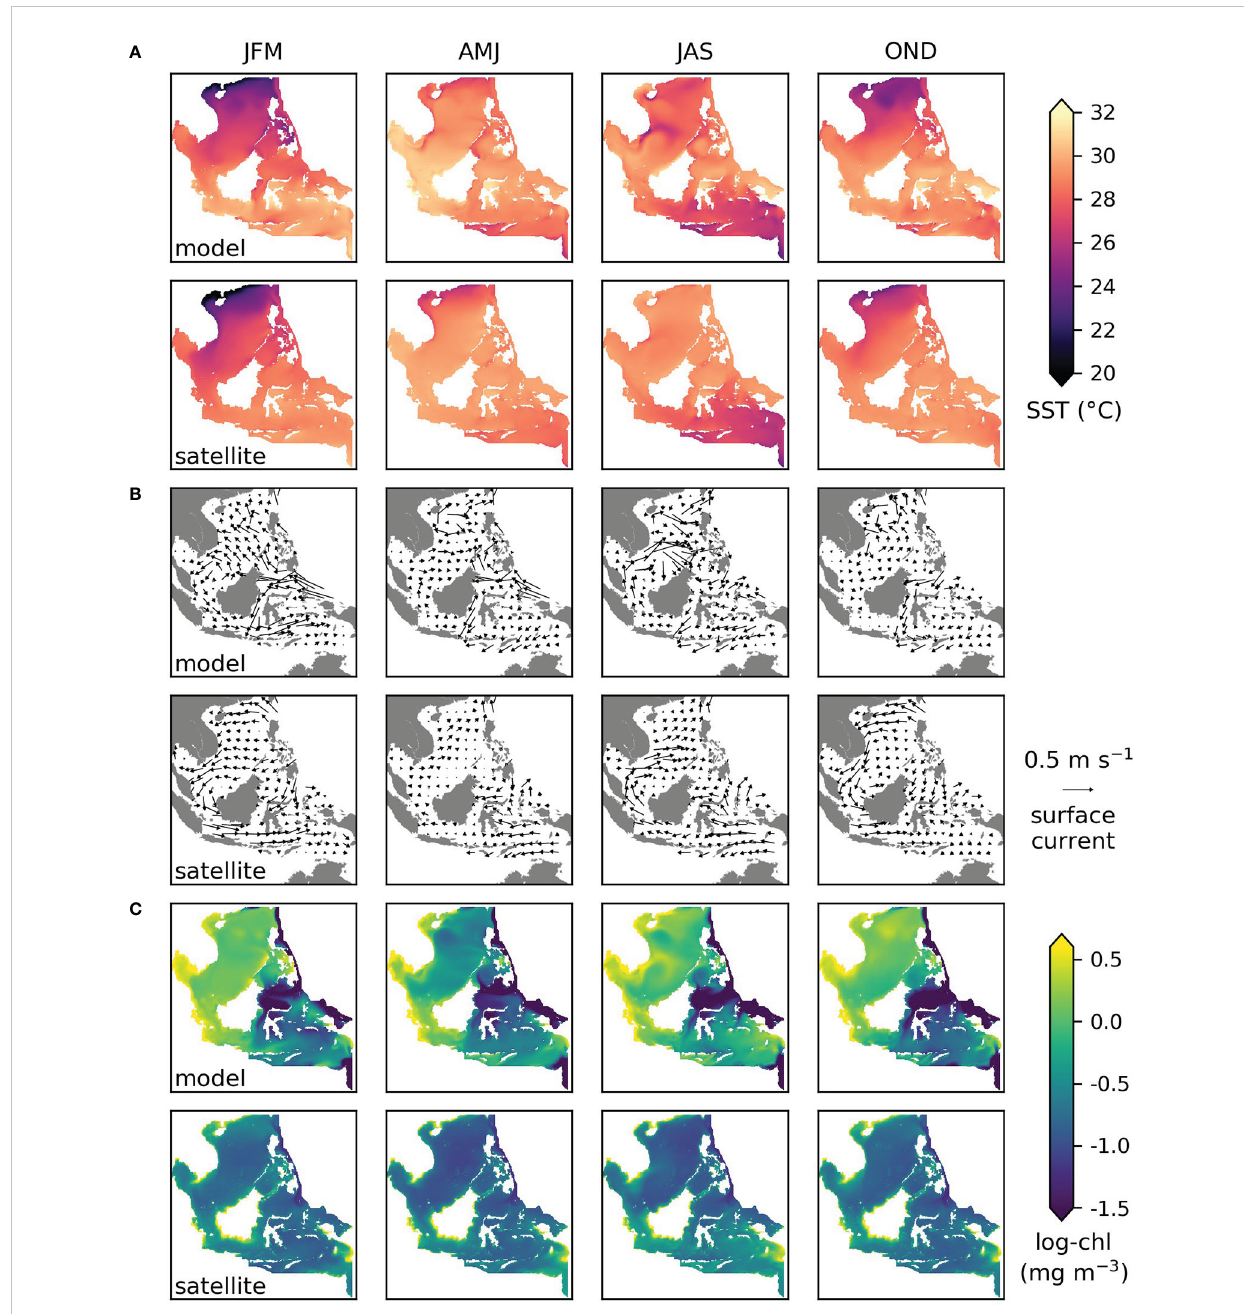
FIGURE 2 Three-month mean conditions for 1998-2017 from the model (upper row) and derived from satellite observations (lower row) for (A) sea surface temperature, (B) surface current speed and direction, (C) surface chlorophyll-a concentration. JFM=January-February-March etc. The satellite-based products are OSTIA reprocessed sea surface temperature, geostrophic+Ekman surface current and Ocean Colour CCI chlorophyll-a, see section 2.6 for